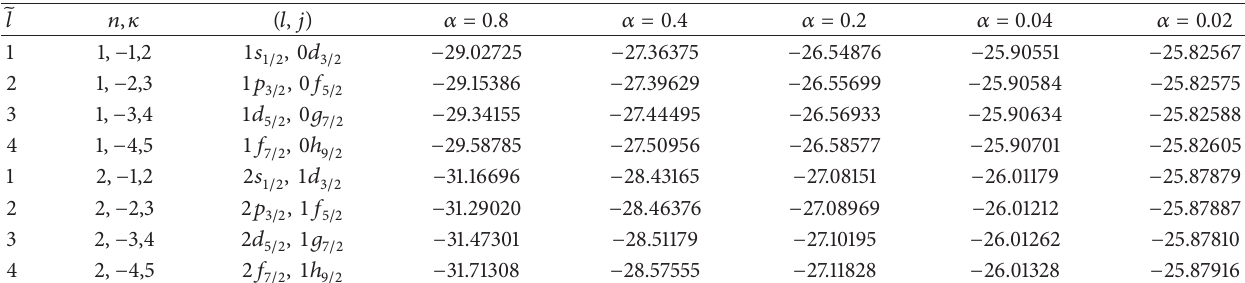
Table 5: The bound state energy eigenvalues in units of fm − 1 of the p -spin symmetry tPT potential for several values of 𝑛 and 𝜅 with 𝐻 = 0 .